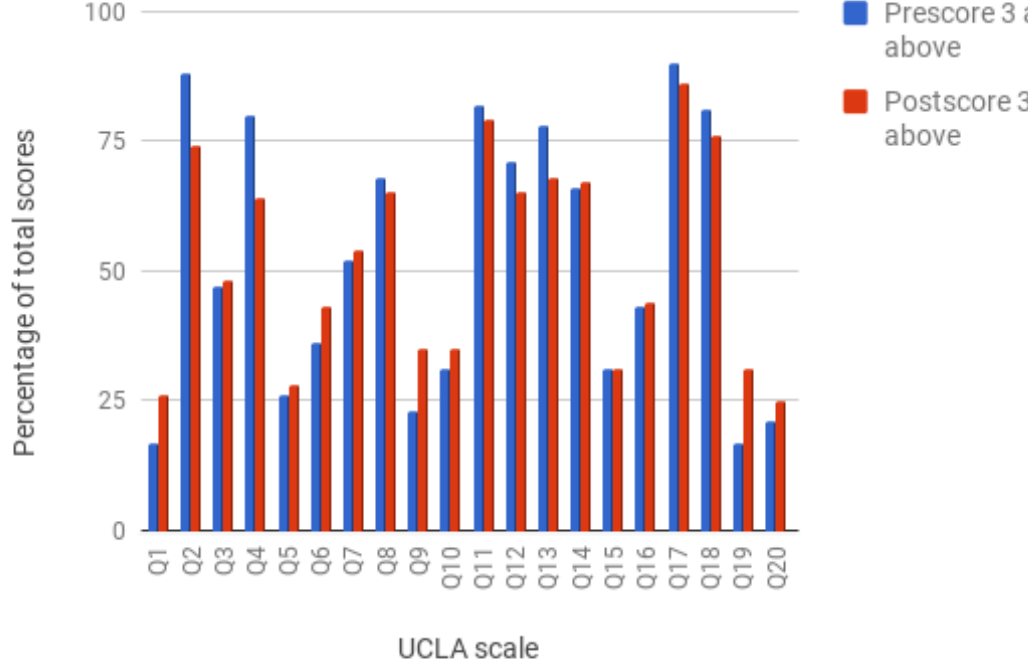
Figure 5. Comparison of pre- and postloneliness ratings of University of California, Los Angeles, questions (Q2, Q4, and Q19 have the largest change in postloneliness ratings). Q: question; UCLA: University of California, Los Angeles.